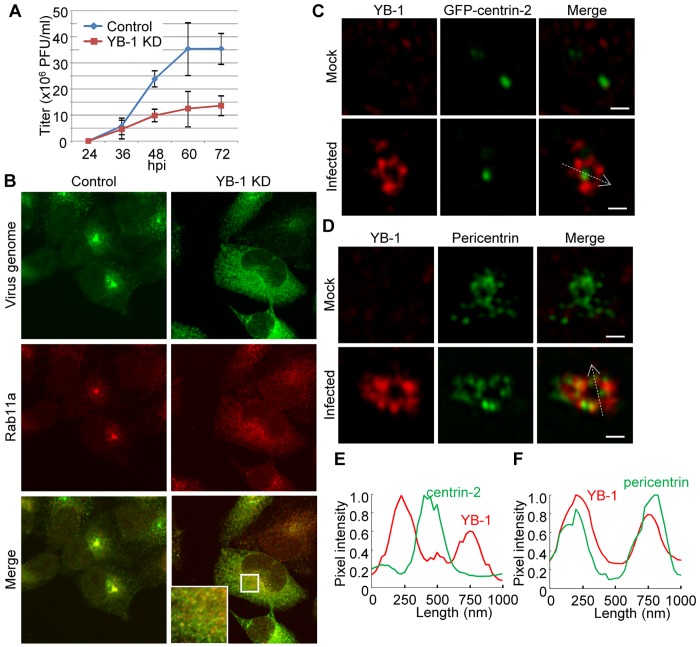
YB-1 is required for pericentrosomal ERC formation.(A) Production of infectious virions. HeLa cells were transfected with non-targeting or YB-1 siRNA. At 48 h post transfection of siRNA, control and YB-1 KD cells were infected with influenza virus at MOI of 0.01. The culture supernatants collected at 24, 36, 48, 60, and 72 h post infection were subjected to plaque assays to examine the production of infectious virions. The average titers and standard deviations determined from three independent experiments are shown. (B) Intracellular localization of the virus genome and Rab11a in YB-1 KD cells. At 48 h post transfection of siRNA, control and YB-1 KD HeLa cells were infected with influenza virus at MOI of 10. At 8 h post infection, immunofluorescence assays were carried out with anti-Rab11a antibody (red), followed by FISH assays using an RNA probe complementary to segment 1 virus genome. Scale bar, 5 μm. (C and E) Centrosomal localization of YB-1 and GFP-centrin-2. At 8 h post infection (MOI = 10), uninfected and infected HeLa cells constitutively expressing GFP-centrin-2 were subjected to indirect immunofluorescence assays with rabbit anti-YB-1 antibody (red). In panel E, quantitative determination of the each signal (centrin-2, green; YB-1, red) was performed along the white dashed arrows shown inside the panel E, bottom panel. Y-axis indicates the normalized pixel intensity. (D and F) Centrosomal localization of YB-1 and pericentrin. At 8 h post infection (MOI = 10), uninfected and infected cells were subjected to indirect immunofluorescence assays with mouse anti-pericentrin (green) and rabbit anti-YB-1 (red) antibodies. In panel F, quantitative determination of the each signal (pericentrin, green; YB-1, red) was performed along the white dashed arrows shown within the panel E, bottom panel. Y-axis indicates the normalized pixel intensity. In panel C and D, all images were acquired with a super-resolution microscopy (3D-SIM; Carl Zeiss). Scale bar, 500 nm.